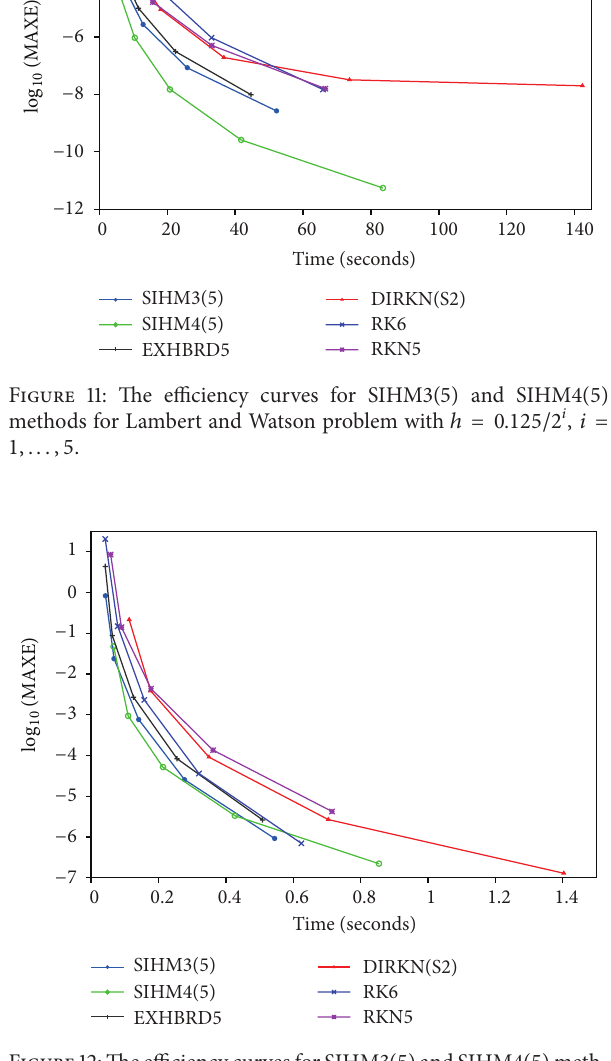
Figure 12: The efficiency curves for SIHM3 (5) and SIHM4 (5) meth- ods for An almost Periodic Orbit problem with ℎ = 0.125/2 𝑖 , 𝑖 = 1,...,5